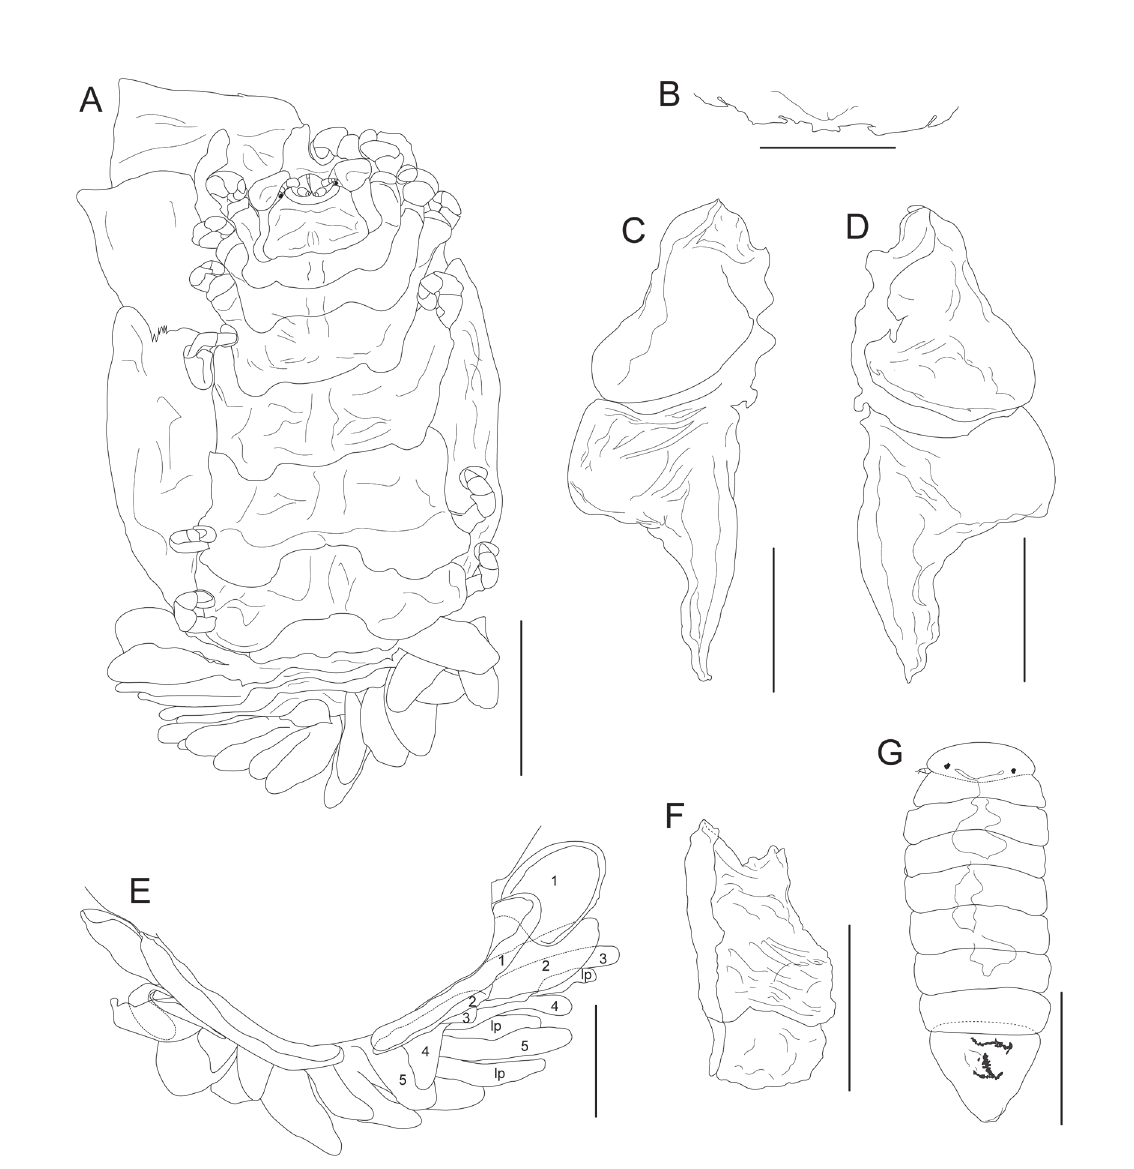
Fig. 5. Stegias clibanarii Richardson, 1904 (CNCR-36487). A . Ovigerous ♀, dorsal view. B . Barbula. C . First oostegite, external view. D . Same, internal view. E . Pleon, ventral view. F . Maxilliped. G . ♂, dorsal view. Numbers indicate pairs of pleopods. Abbreviation: lp = lateral plate. Scale bars: A = 1.0 mm; B–G =